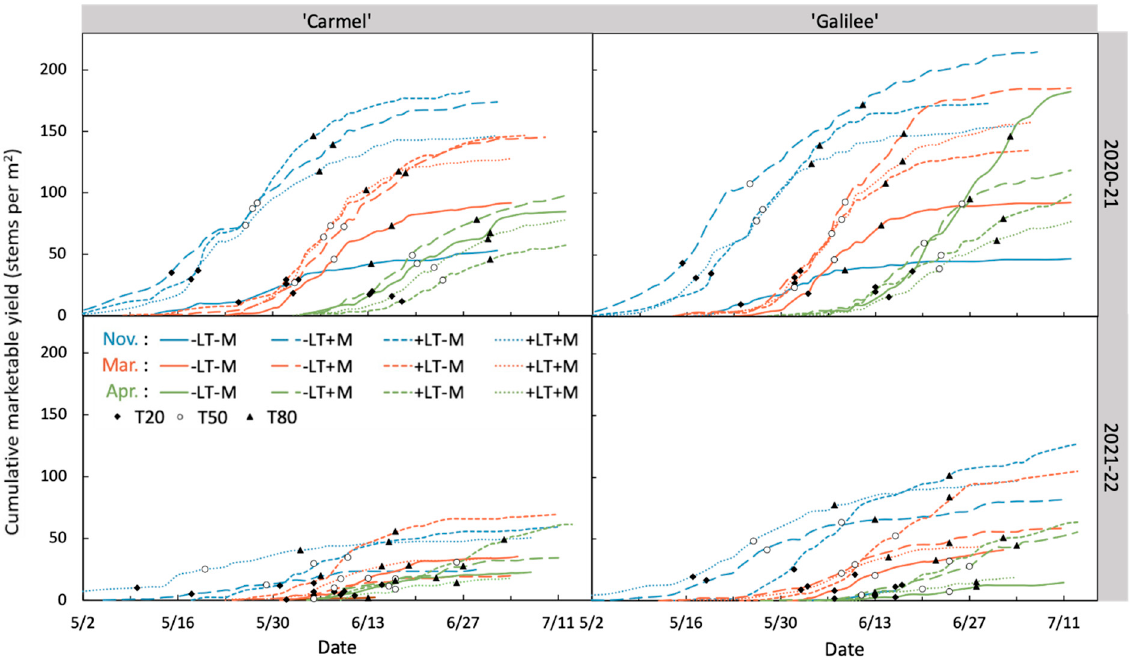
Figure 3. Field cumulative marketable yield of ‘Carmel’ ( left ) and ‘Galilee’ ( right ) anemone in 2020-21 ( top ) and 2021-22 ( bottom ) in North Logan, UT, by planting date (November—blue; March—red; April—green) that were left uncovered ( − LT − M—solid) or insulated with mulch ( − LT + M—long dashes), a low tunnel (+LT − M—short dashes), or mulch and a low tunnel (+LT + M—dots). T20 (diamonds), T50 (circles), and T80 (triangles) mark when 20, 50, and 80% of the total marketable yield is achieved,